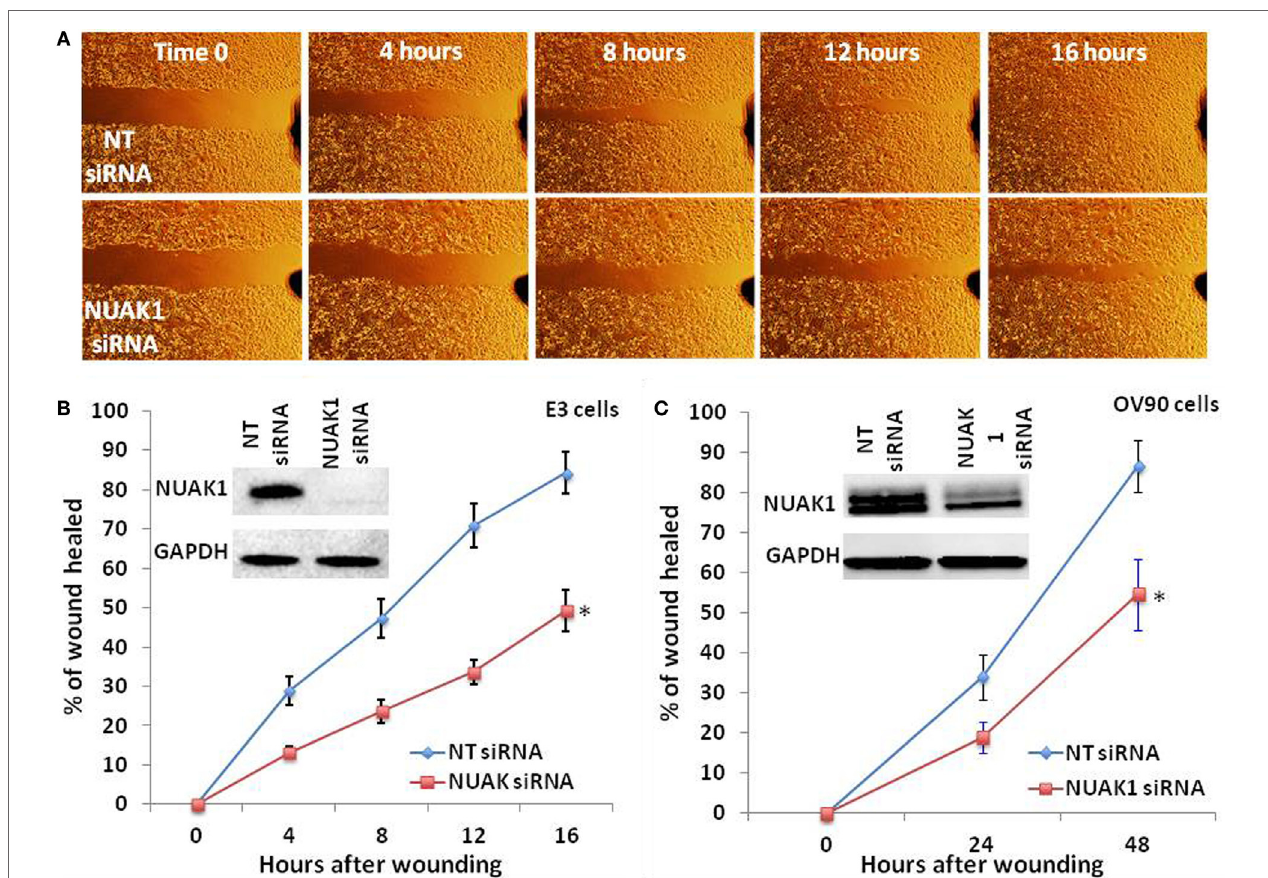
FigUre 4 | nUaK1 regulates the migratory potential of chemosensitive and chemoresistant high grade serous ovarian cancer cells . (a) Time-course wound healing assay micrographs of chemoresistant ovarian cancer cells (E3) following NUAK1 knockdown by small interfering RNA (siRNA). (B) Representative rates of wound healing in E3 cells following siRNA-mediated knockdown of NUAK1 (*Paired t -test p = 0.005734). (c) Representative rates of wound healing in chemosensitive ovarian cancer cells (OV90) following siRNA-mediated knockdown of NUAK1 (*Paired t -test p = 0.01315). Inset immunoblot images in (B,c) detail confirmation of NUAK1 knockdown. Data in (B,c) represent percent of wounds healed relative to areas measured at t = 0 h. Data points reflect duplicate, technical replicates, and data sets are representative of triplicate biological